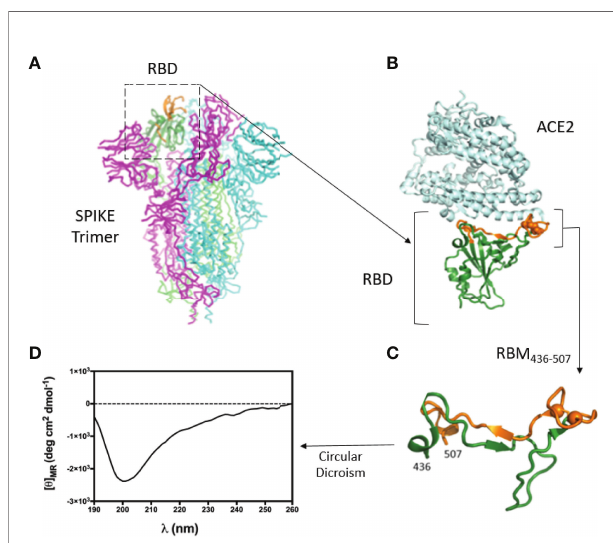
FIGURE 1 | 3D structure of the RBD-ACE2 complex and CD of RBM 436-507 . (A) Atomic 3D structure of the S trimer in the prefusion conformation (27). RBD is shown in ribbon representation (dark green). Region 476-507 is in orange. (B) Complex between RBD (green-orange) and ACE2 receptor (light cyan) (12). (C) Conformation of the RBM peptide (436-507) within the RBD. Cysteine residues are shown as spheres. (D) Circular Dichroism of RBM 436- 507 synthetic peptide used in this